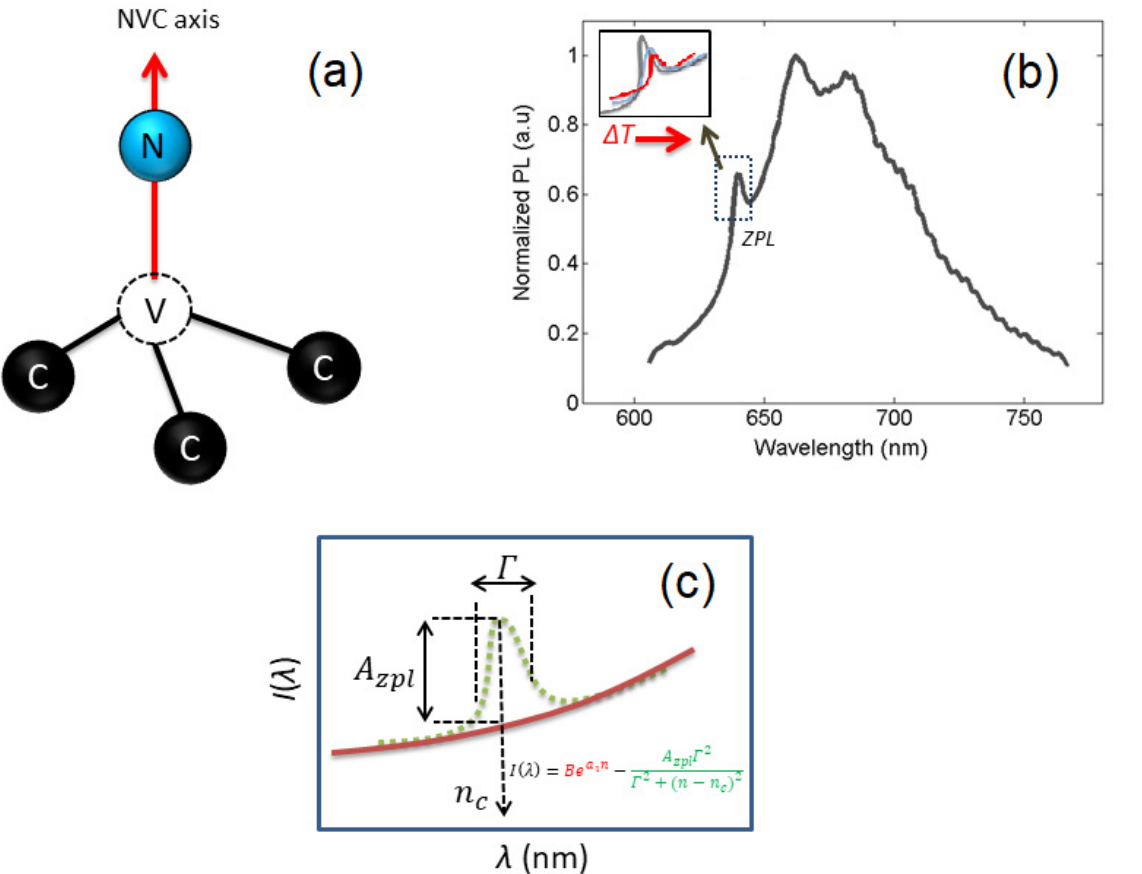
Figure 1. Optical spectroscopy of NV center. ( a ) The structure of the NV center in a diamond comprising a nitrogen atom connected to a vacancy (center). The NV center is optically excited typically with 590–532 nm lasers, whereas the emission lies within 500–800 nm. ( b ) PL spectra of a single NV center displaying ZPL (638 nm) and PSB; inset shows the temperature-dependent shift in ZPL. ( c ) The mathematical representation of the shape of ZPL using a Lorentzian function with an exponential background.